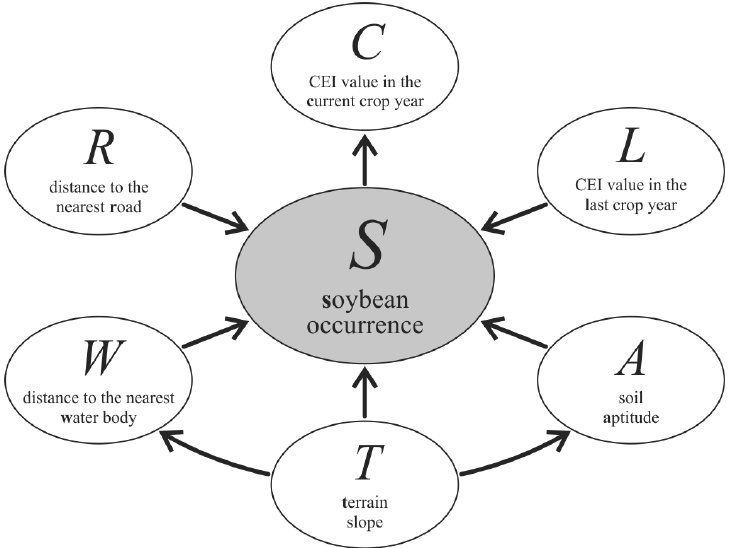
Figure 4. Directed Acyclic Graph (DAG) encoding assertions of conditional (in)dependence among the variables and representing the designed Bayesian Network graphical model for the case study of soybean occurrence in Mato